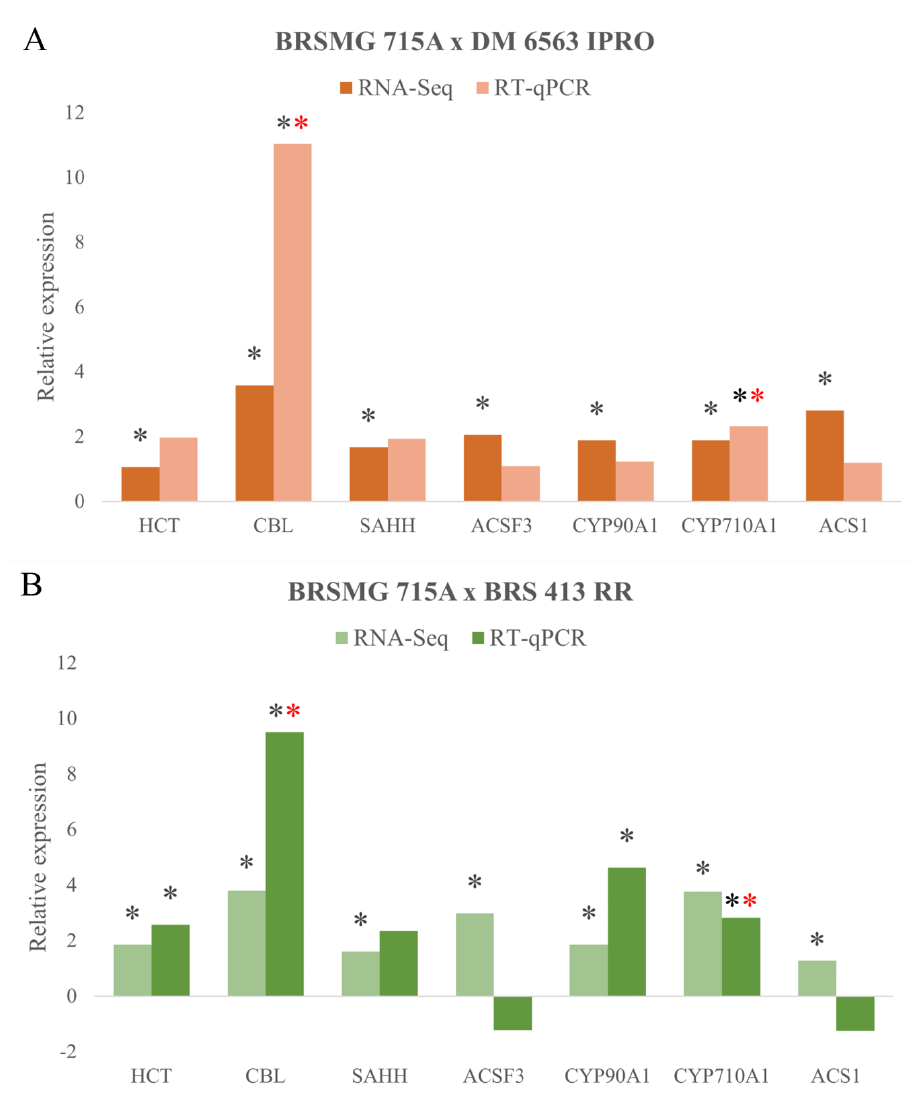
Figure 5. Relative expression of the HCT , CBL , SAHH , ACSF3 , CYP90A1 , CYP710A1 , and ACS1 genes in freshly harvested whole soybean seeds. Positive values represent expression in the black seed coat cultivar BRSMG 715A compared to the yellow seed coat cultivars BRS 413 RR ( A ) and DM 6563 IPRO ( B ). For RT-qPCR (2 −ΔΔCt ), the statistical analysis was performed using the t -test ( p ≤ 0.1) and Wilcox test ( p ≤ 0.05). For RNA-Seq (log2FC) analysis, FDR ≤ 0.05 was used. Asterisks (*) represent values with a significant difference. Red asterisks represent significant values according to the Wilcox test.